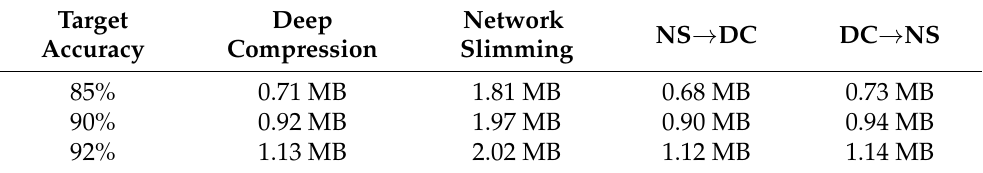
DC and DC NS for DenseNet-40. → →